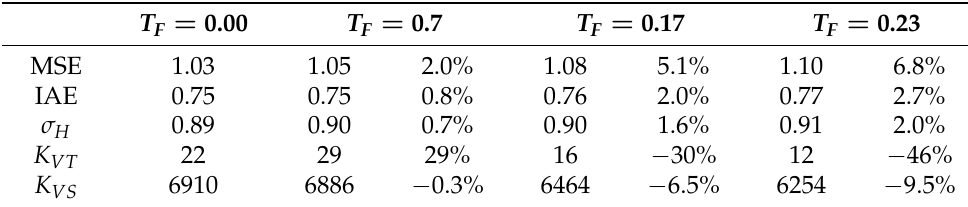
Table 13. Control error filter impact on G 2 ( s ) .